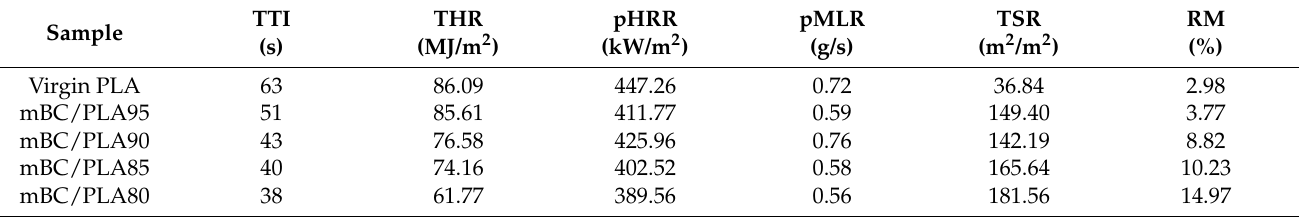
Table 5. Main CONE test results for mBC/PLA composites.